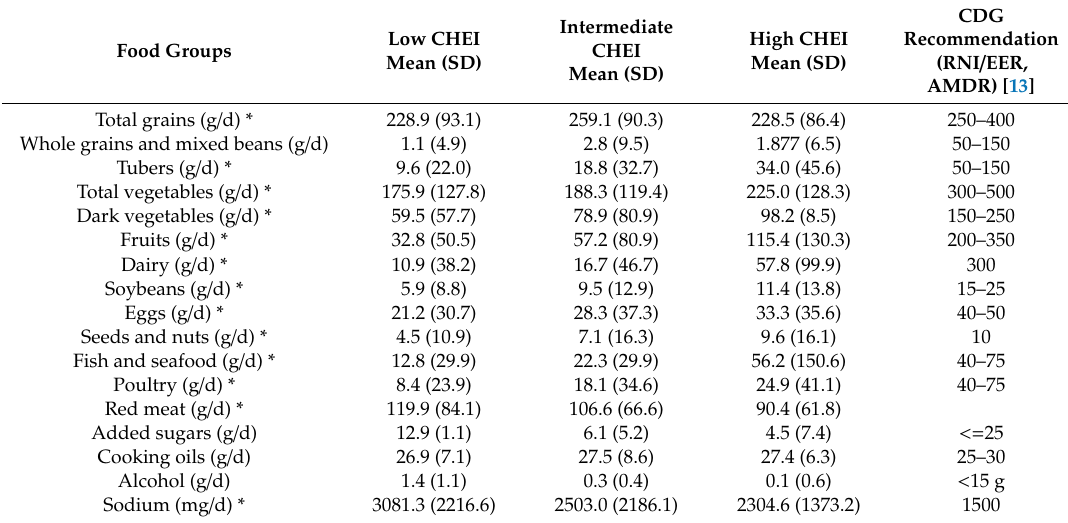
Table 4. Mean value of foods intake among low, intermediate, and high CHEI scoring